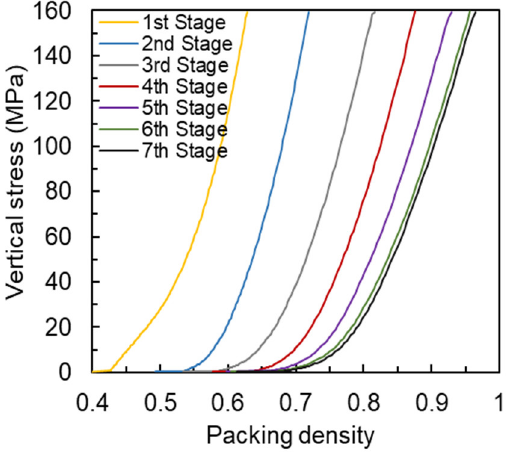
Figure 5. Relationship between vertical stress and packing density for different stages of pressing for the Itabira sample in a narrow size range of 106–75 µm.